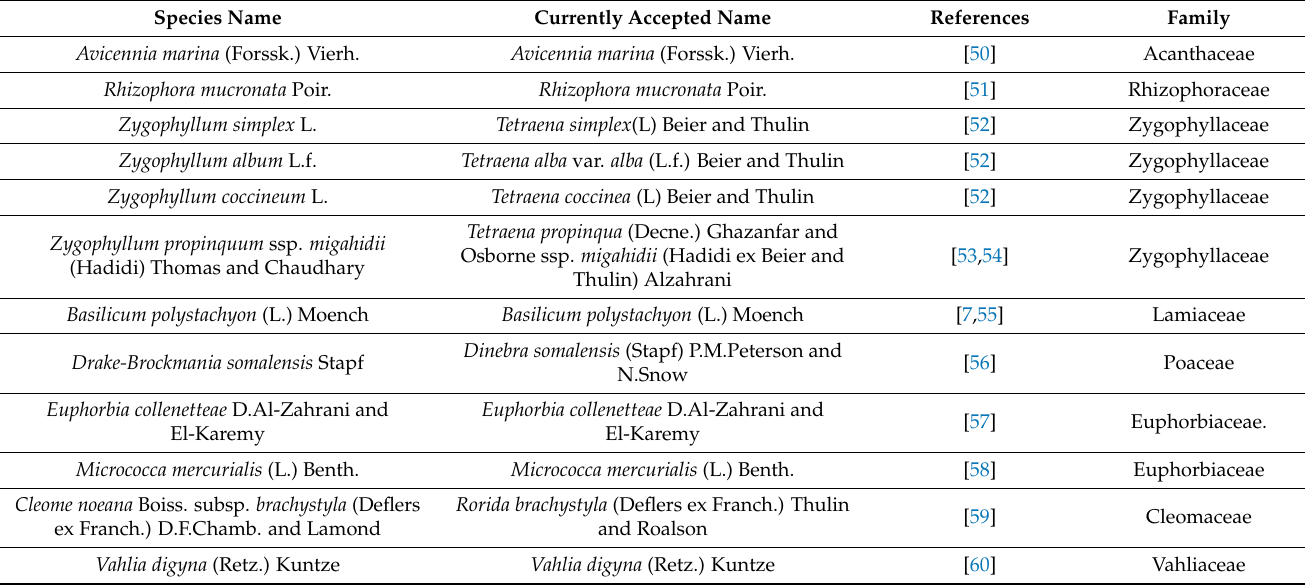
Table 1. Summary of the nomenclature changes of the species under study (updates, references,